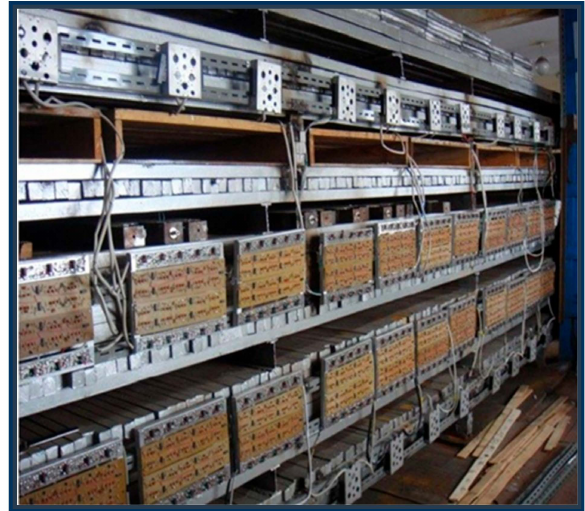
Figure 6. Hadron block of the ionization-neutron